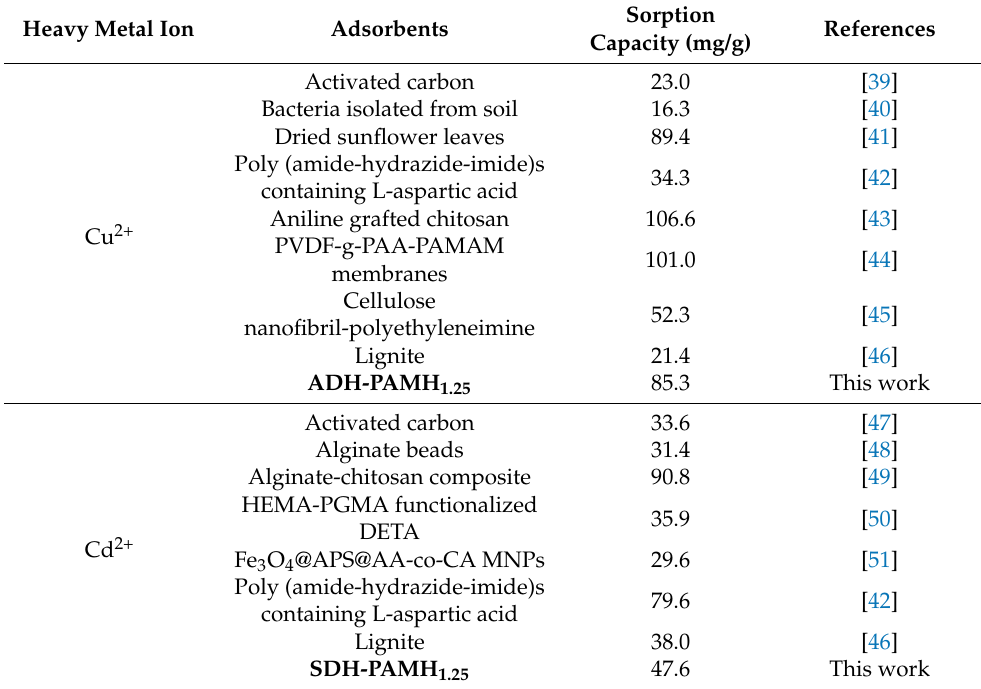
Table 1. Cu(II) ion sorption abilities of various